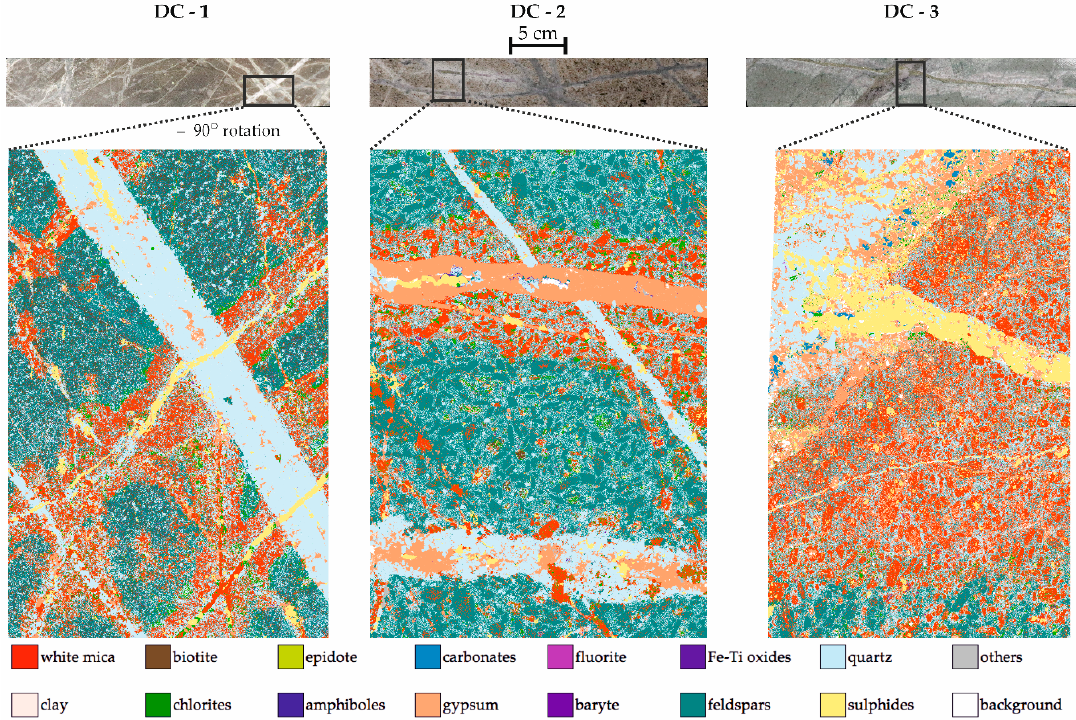
Figure 5. SEM-MLA mineral maps used for the validation and evaluation of the mineral mapping based on hyperspectral scans.